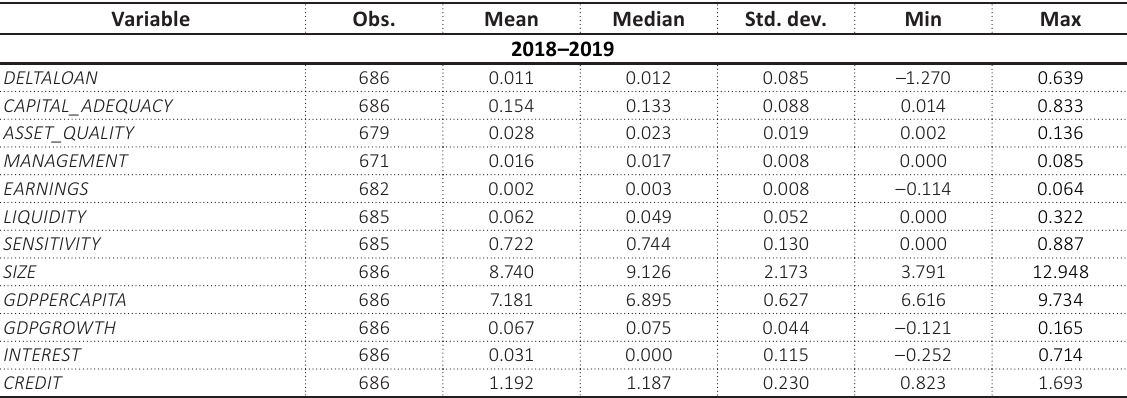
Table 2. Descriptive